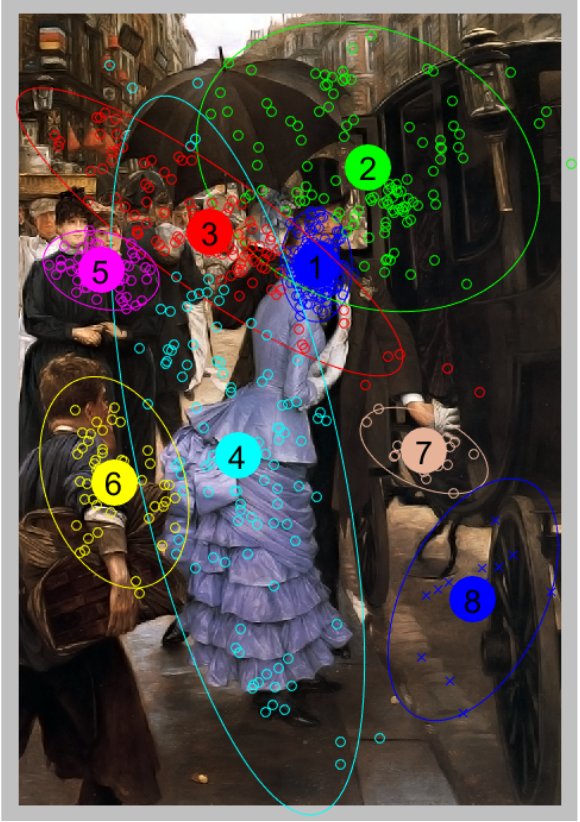
Figure. 2. Result of clustering for EM